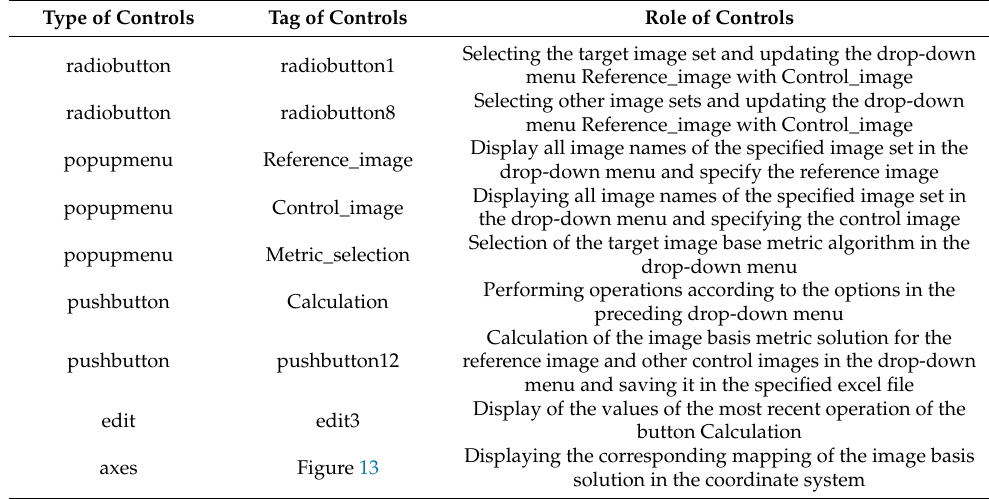
Table 3. Types, labels, and roles of controls used in the Module 3 interface.